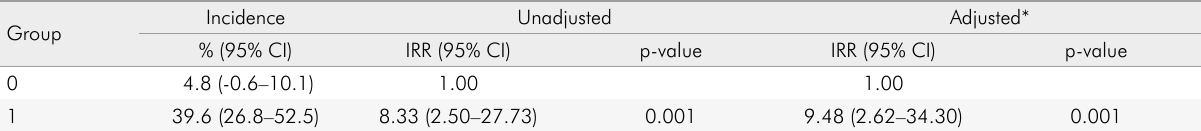
Table 2. Incidence of caries activity over the study period and its association with independent variables. Unadjusted and adjusted Poisson regression models (n = 121).